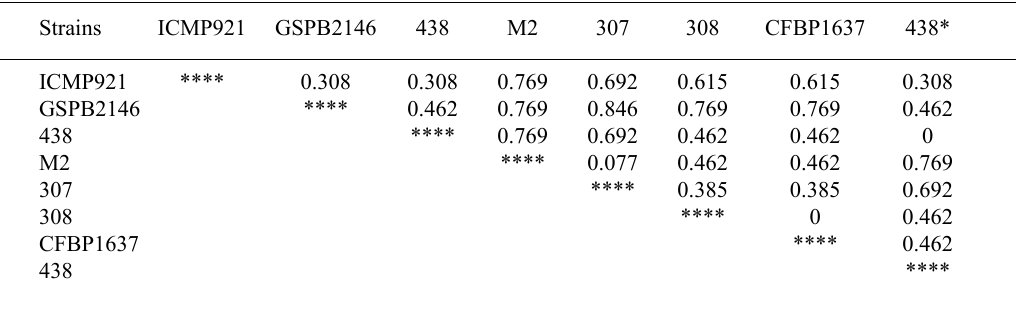
table 3. Dissimilarity index obtained with Pme I